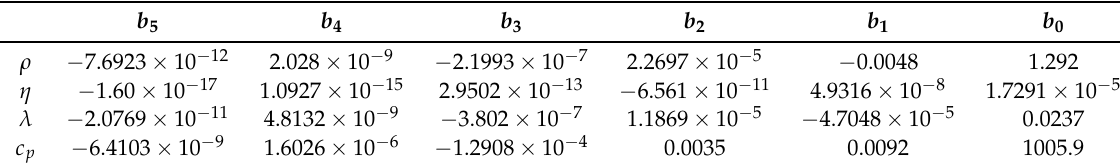
Table 3. Coefficients for properties of air.